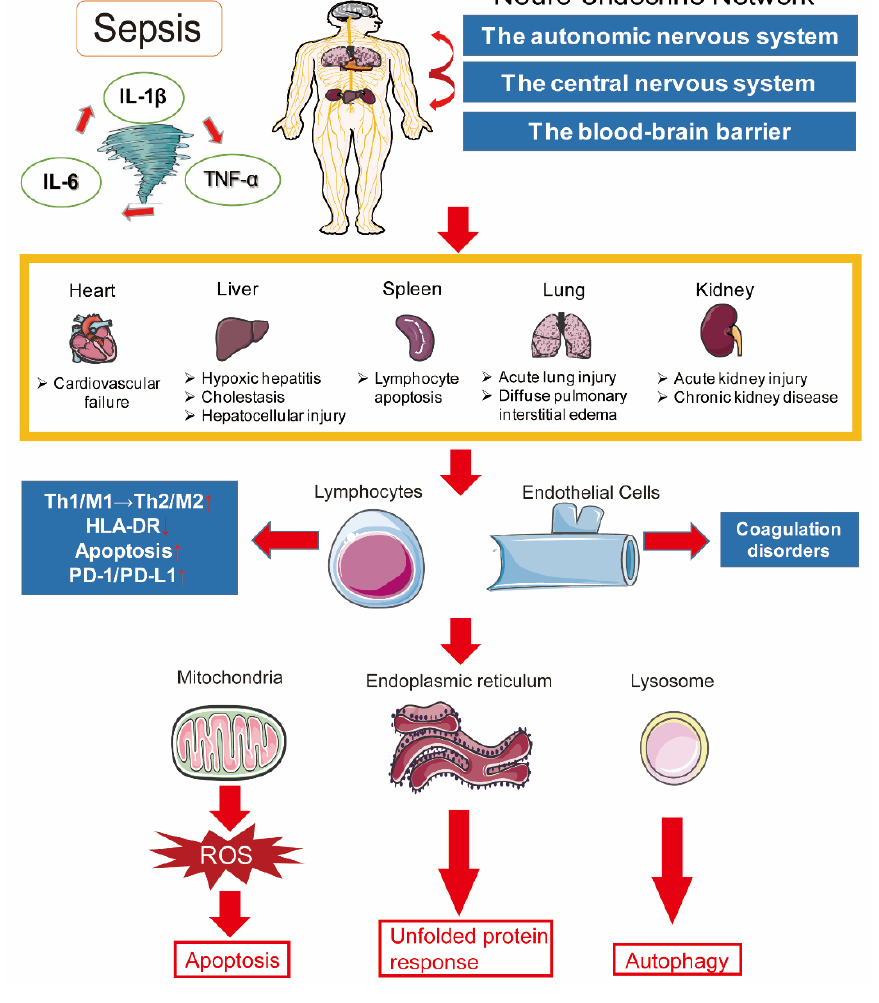
Figure 1. The complex pathogenesis of sepsis.